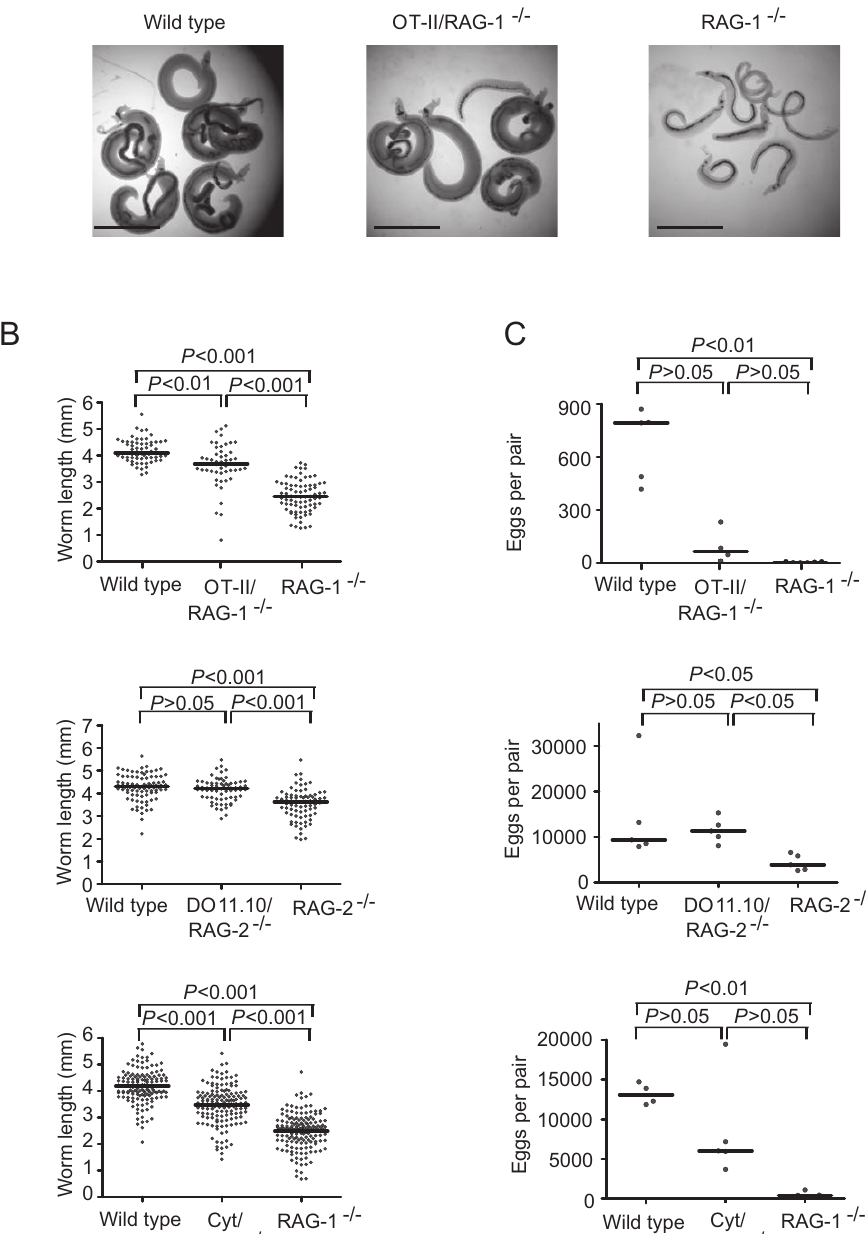
Figure 2. Recognition of schistosome antigens by CD4 + T cells is dispensable for S.mansoni development. (A) Wild type, OT-II/RAG-1 -/- and RAG-1 -/- mice were infected with S. mansoni and parasites were recovered from the portal tract at 6 weeks post infection. Representative micrographs of parasites recovered from wild type, OT-II/RAG-1 -/- and RAG-1 -/- mice are shown. Bar=1 mm. (B) Length of male worms and (C) egg production by schistosome pairs from OT-II/RAG-1 -/- (top), DO11.10/RAG-2 -/- (center) and Cyt/RAG-1 -/- (bottom) mice and their appropriate wild type and RAG -/- controls at 6 weeks post infection. Mean values are represented by horizontal bars. Groups of 4–5 mice were used for each experimental condition. Data are representative of at least two independent